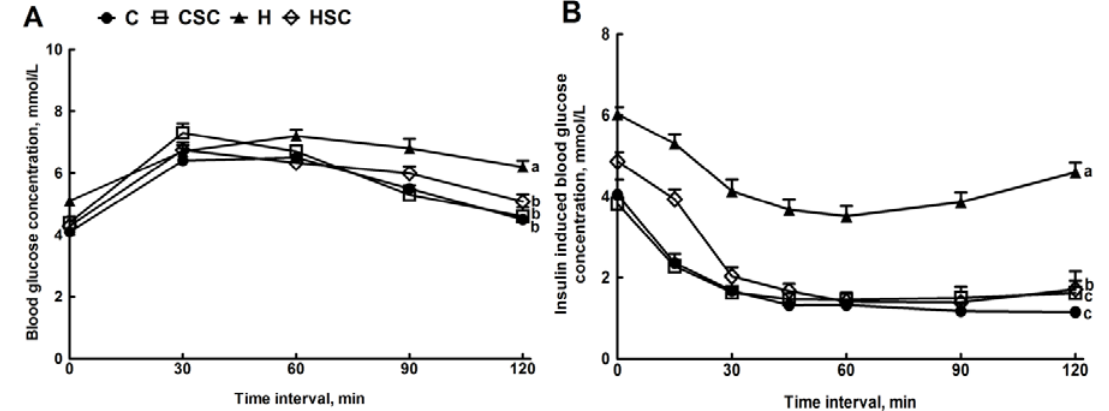
Figure 1. Effect of microalgal mixture treatment on oral glucose tolerance ( A ) and insulin tolerance ( B ) in C, CSC, H and HSC rats. Values are mean ± SEM, n = 10. Endpoints means without a common letter differ significantly at p < 0.05. C, corn starch-fed rats; CSC, cornstarch rats treated with Scenedesmus dimorphus + Schroederiella apiculata ; H, high carbohydrate, high fat diet-fed rats; HSC, high carbohydrate, high fat-rats treated with Scenedesmus dimorphus + Schroederiella apiculata